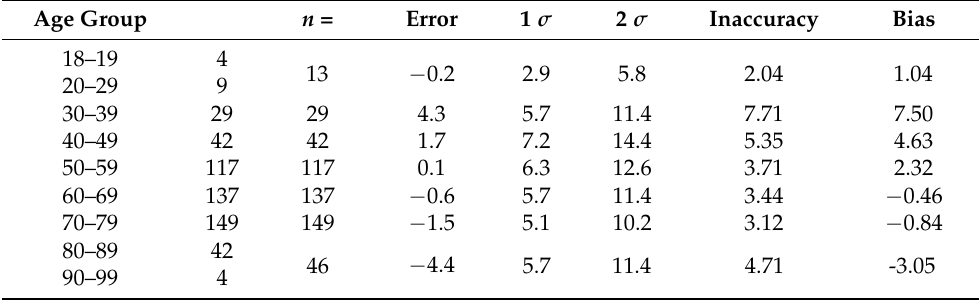
Table 6. TCM results by decade